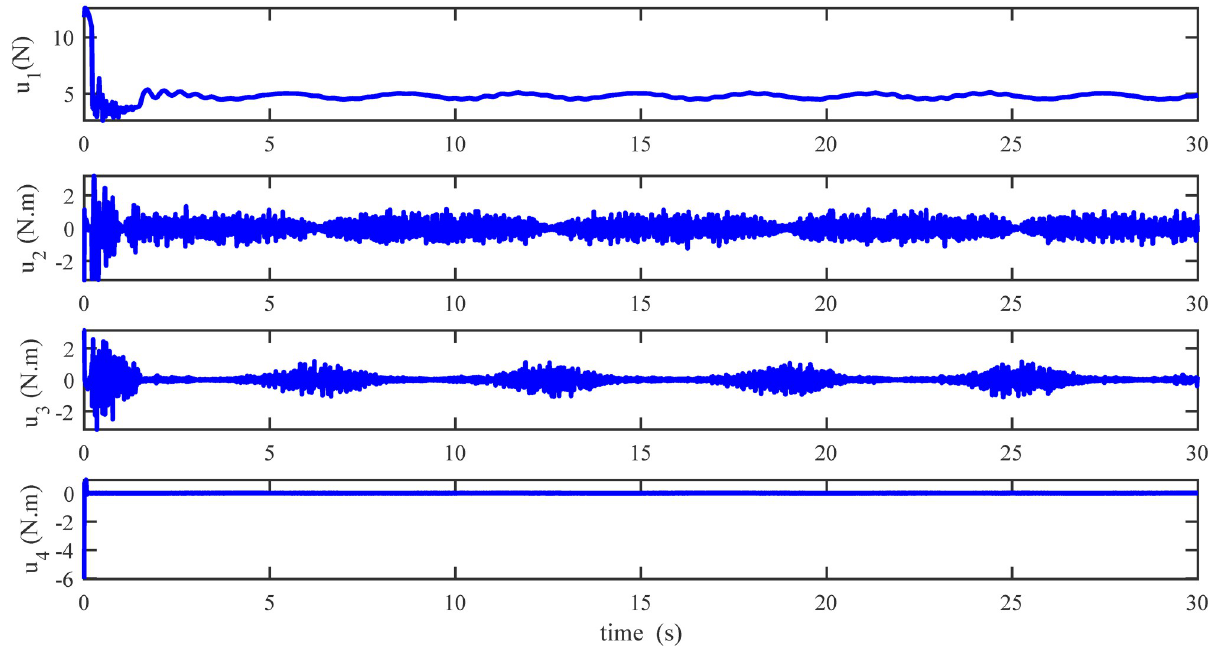
Fig 18. Results of the inputs under the proposed